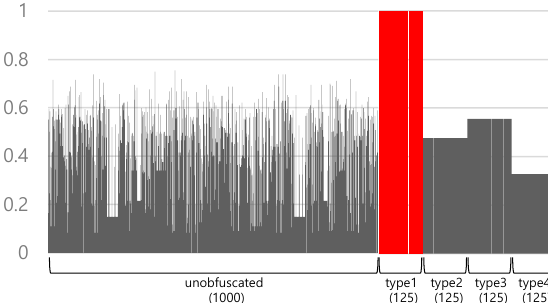
Figure 4. Classification result according to the obfuscation type 1 threshold in the conventional AST (FPR: False Positive Rate, FNR: False Negative Rate).